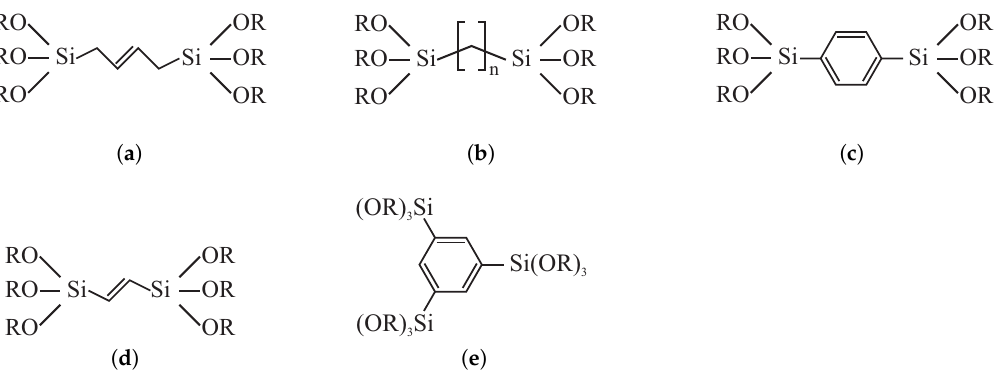
Figure 6. A schematic representation of the bridged silsesquioxane monomers applied in [111] (( a , b ) for n = 2, 3, 6, 8, 10 ( c )) and in [112] (( b ) for n = 1, 2, ( c – e )). R = C 2 H 5